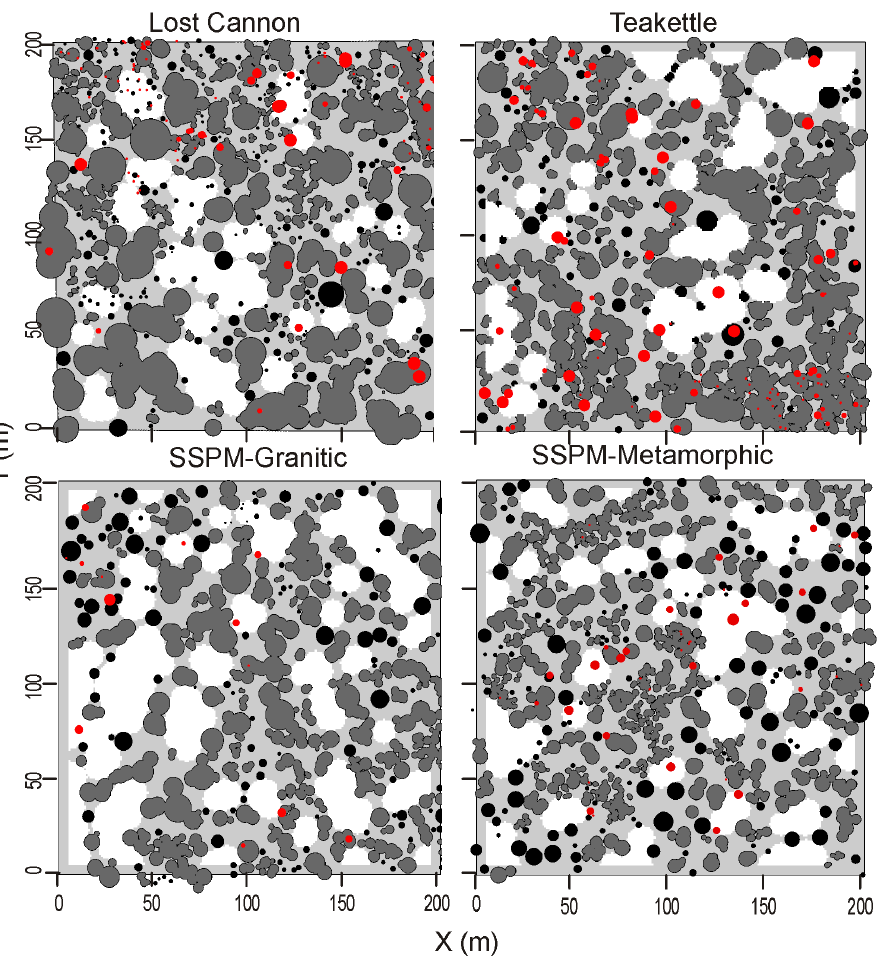
Figure 7. Stem maps of trees (diameters . 5 cm) of four old-growth Jeffery pine-mixed conifer forests. Tree patches (gray) and individual trees (black circles) are defined by crown diameters; two or more trees with overlapping crowns define a patch (see Table 3). White areas represent gaps in the forest (see Table 5). Red circles are snags defined by DBH (cm).